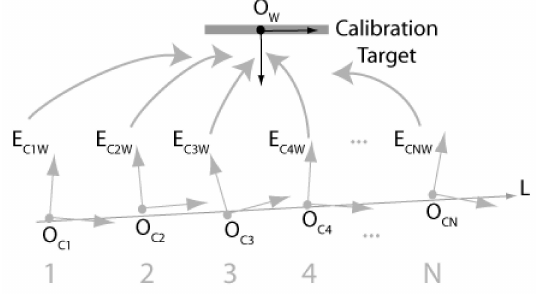
Figure 7. Calibration of translation vector L . The pose of the camera reference frame O Ci (for i = 1 . . . N ) with respect to the reference frame of the calibration target O W is estimated with the procedure described in the preceding section. The direction of the line, which is the estimate of L , is obtained from the principal component analysis of the set of positions O C 1 to O CN